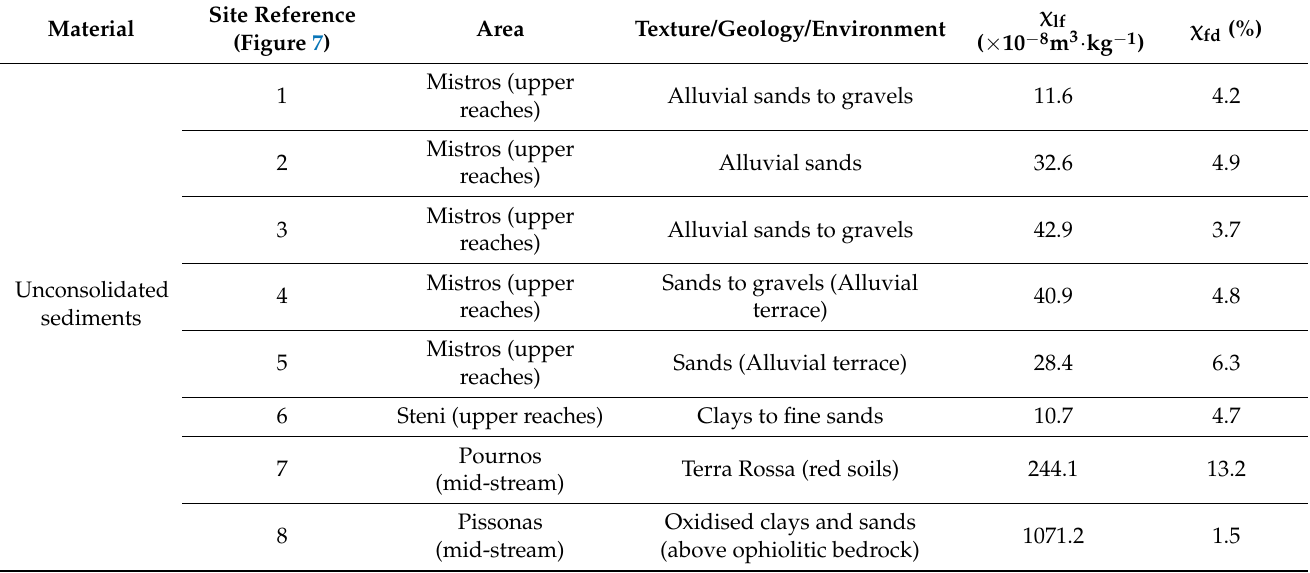
Figure 8. Location map of the samples studied for magnetic parameters with geology of the Lilas catchment. Grey squares: modern towns. The numbers refer to Table 3. Table 3. Magnetic susceptibility results for samples coming from the Lilas catchment. Refer to Figure 7 for exact location of the sampling